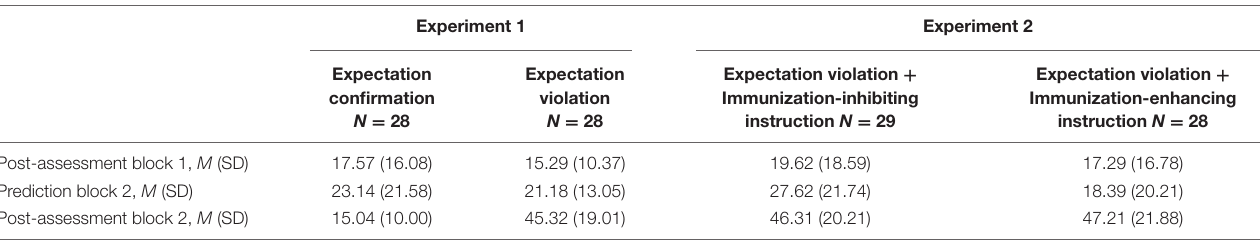
TABLE 3 | Results of the manipulation